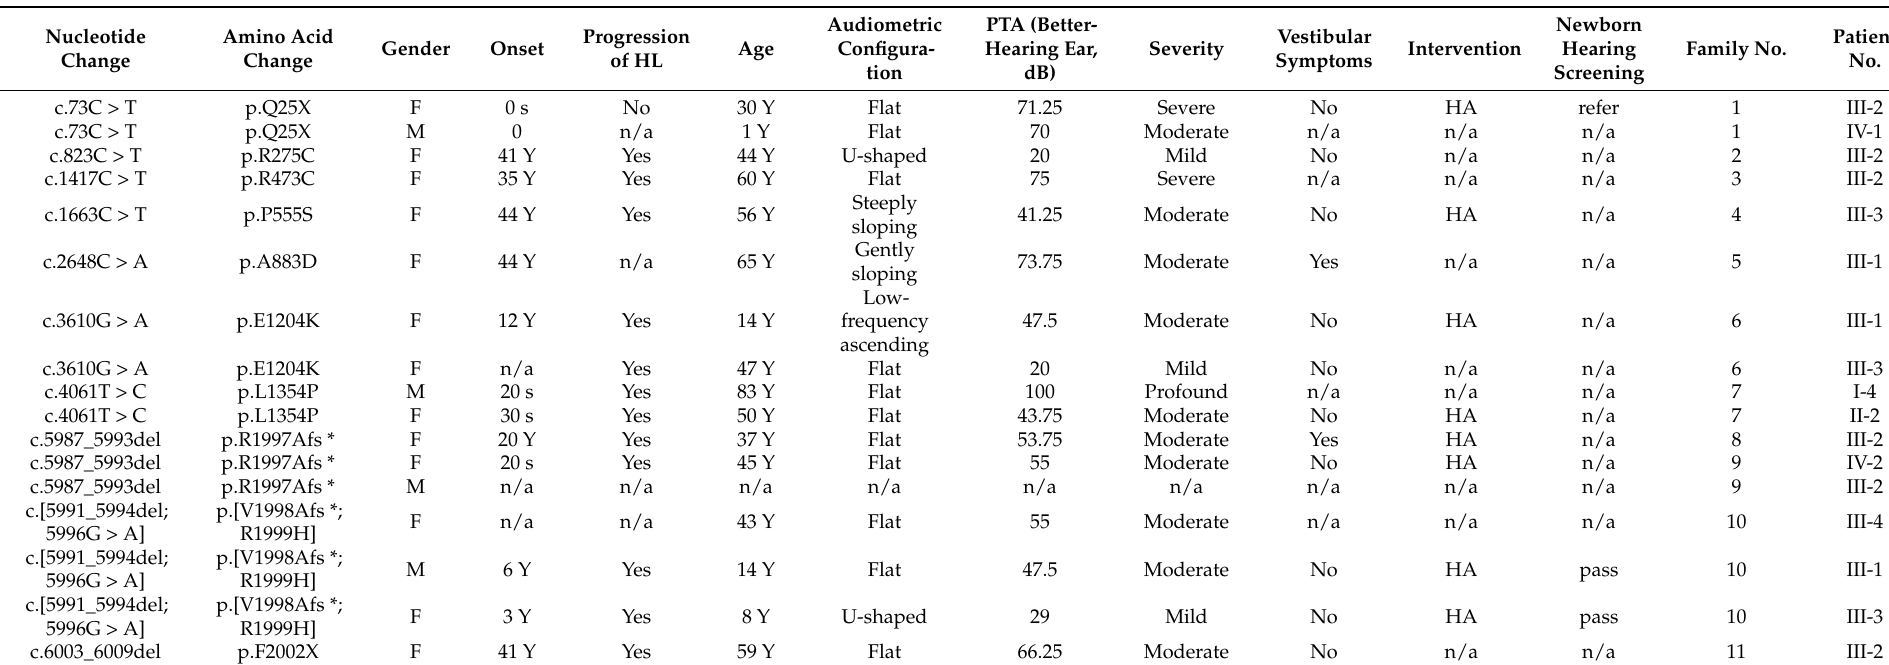
Table 1. Variants and clinical information for MYH14 -associated HL patients and affected family members identified in this study (all MYH14 variants are indicated in